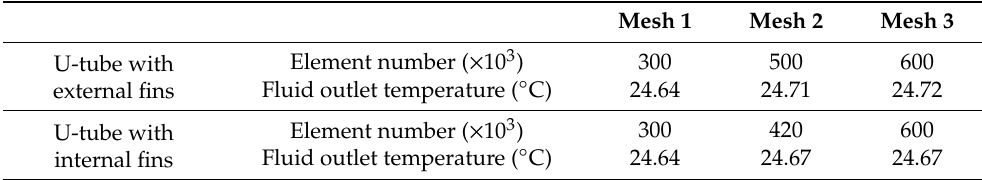
Table 3. Grid-independency test of finned U-tube GHEs.